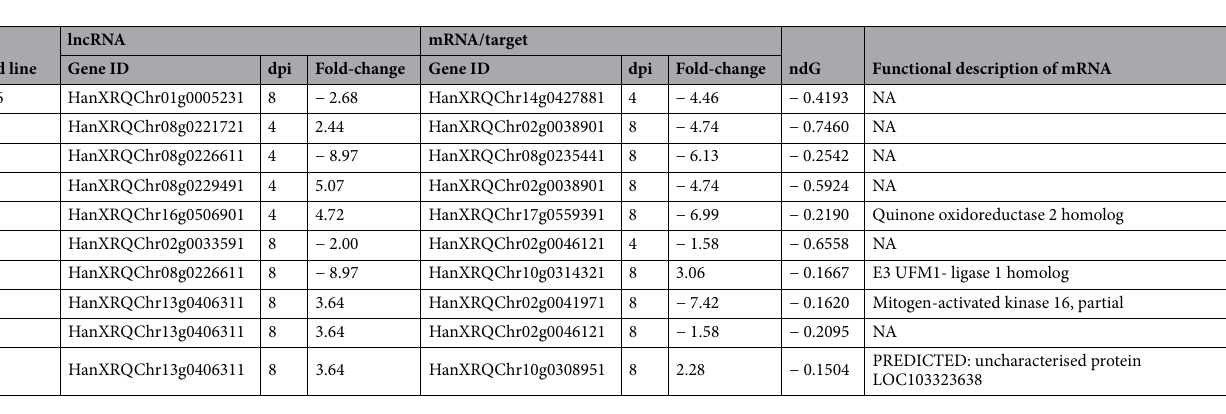
Table 3. Putative lncRNA-mRNA interactions within DEGs. ndG normalised free energy, NA not